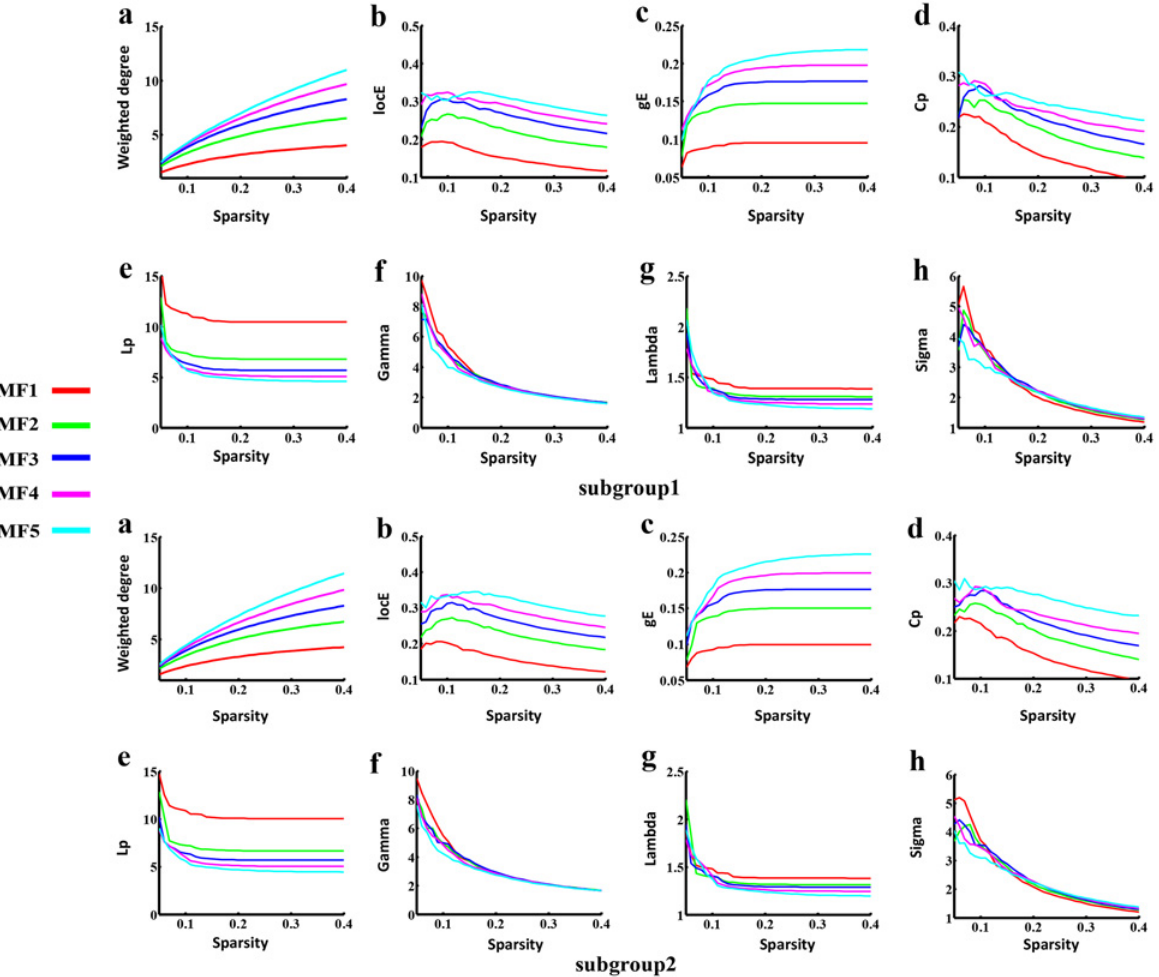
Fig 6. Split-half reproducibility of global topological patterns in both subgroups. From top to bottom, subgroup1 and subgroup2 were presented respectively. Both subgroups had the similar patterns with the whole group results (Fig 3), showing that ultra-low frequency bands (IMF5) have both salient local and global connectivity patterns. The saliency of small-worldness dynamically covered different frequency bands at various density intervals.